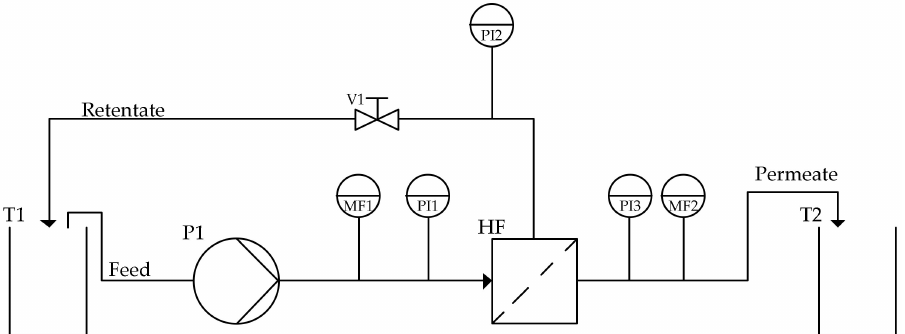
Figure 7. Ultra- and diafiltration process flowsheet: T1 (feed reservoir), P1 (feed pump), MF1 (feed mass flow indicator), PI1 (feed pressure indicator), HF (hollow-fiber module), PI2 (retentate pressure indicator), V1 (pressure control valve), PI3 (permeate pressure indicator), MF2 (permeate mass flow indicator), and T2 (permeate